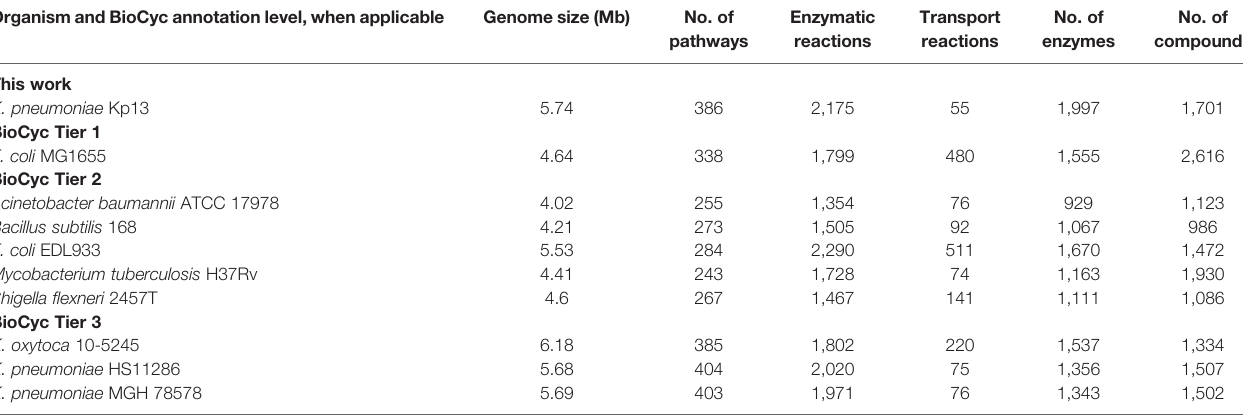
TABLE 1 | Key characteristics of the metabolic reconstruction of K. pneumoniae Kp13 compared to other models produced using the BioCyc ontology. Organism and BioCyc annotation level, when applicable Genome size